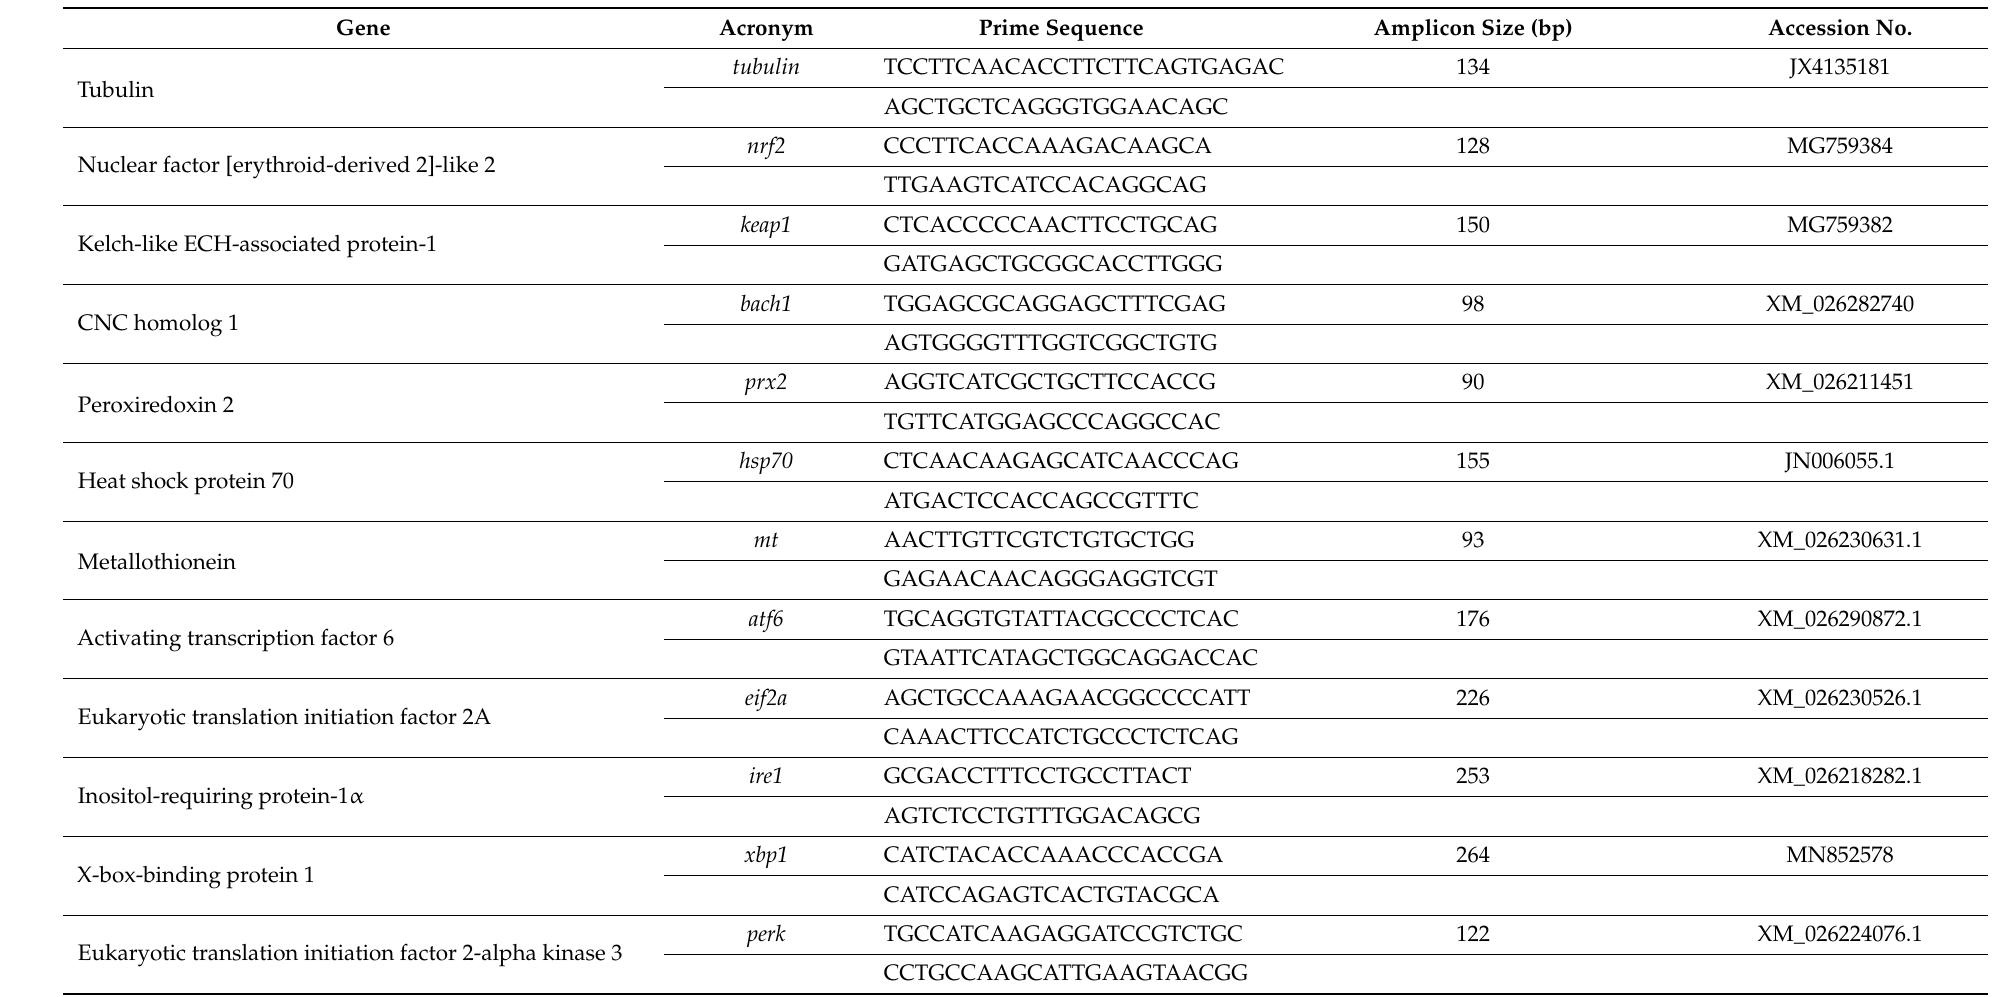
Table 2. Sequences of the primers used for qRT-PCR analysis in gibel